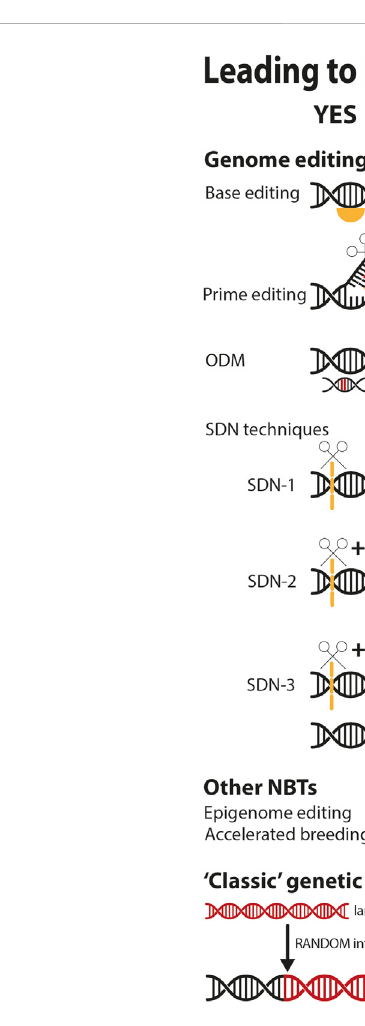
FIGURE 2 Status